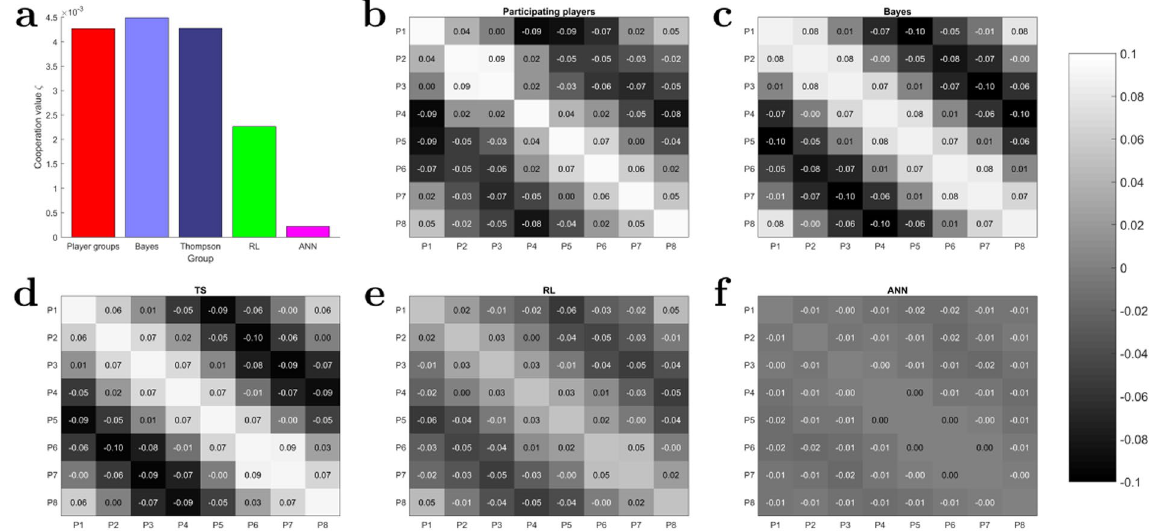
Figure 5. Action time correlation. ( a ) Cooperation values of all groups computed by the covariance between players action time correlation and success probabilities. ( b ) Action time correlation between all pairs of human players. ( c – f ) Action time correlation between all pairs of simulated players for the different models. For a level of significance α = . 0 05 , we find that all correlations are significantly different from